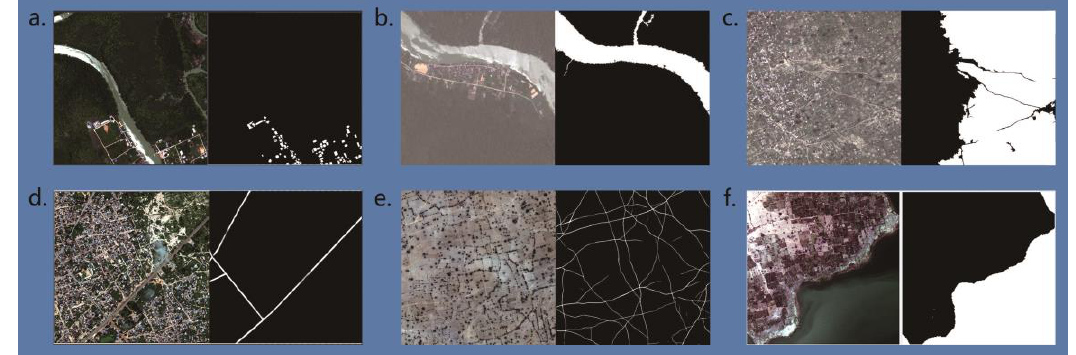
Fig.5. The results of identification